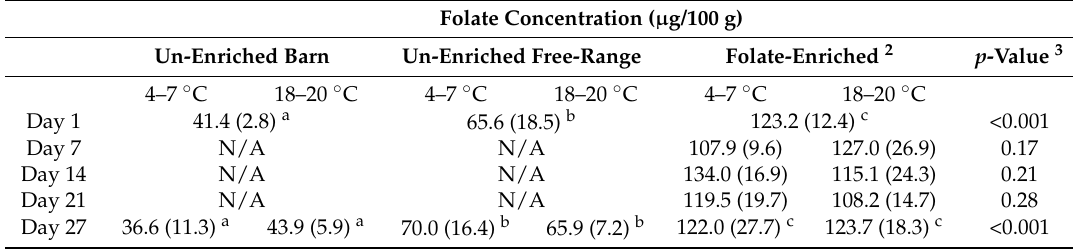
Table 1. Total folate content ( µ g/100 g) of eggs following 27 days storage at refrigerator